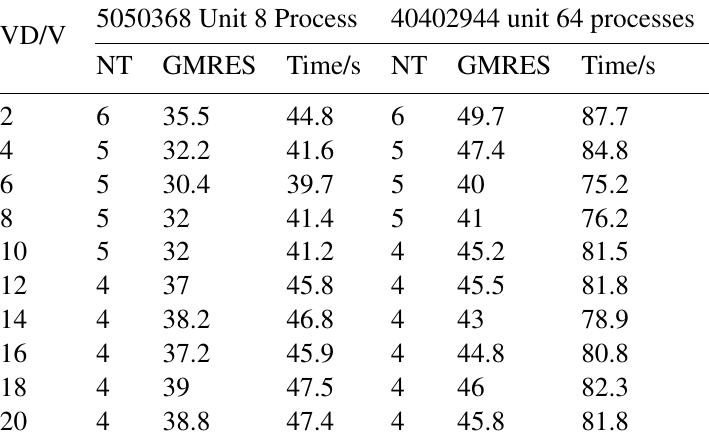
Table 2 MOSFET numerical simulation scalability test